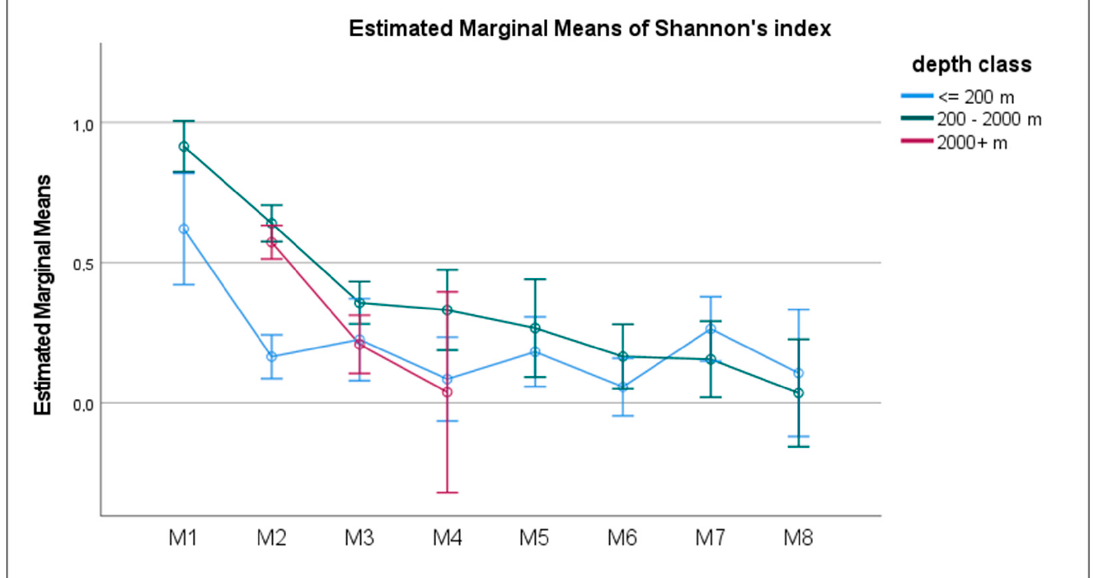
Figure 16. GLM estimated marginal means for geographical subzone and depth class (Shannon index). Estimated means are corrected for the effort covariate.